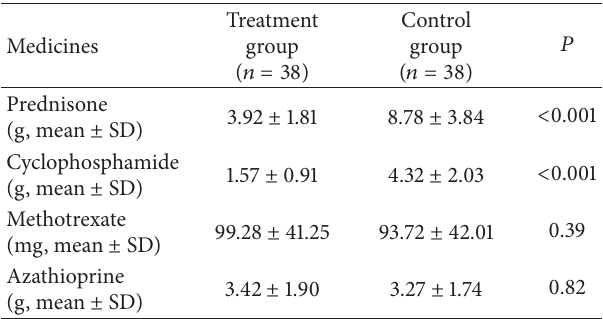
Table 4: Cumulative doses of corticosteroid and immunosuppres- sive agents for SLE in 12 months after